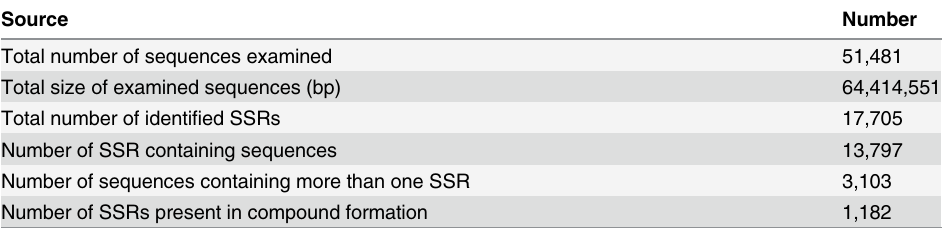
Table 6. General statistics of SSR search in ‘ Hangbaishao ’ transcriptome